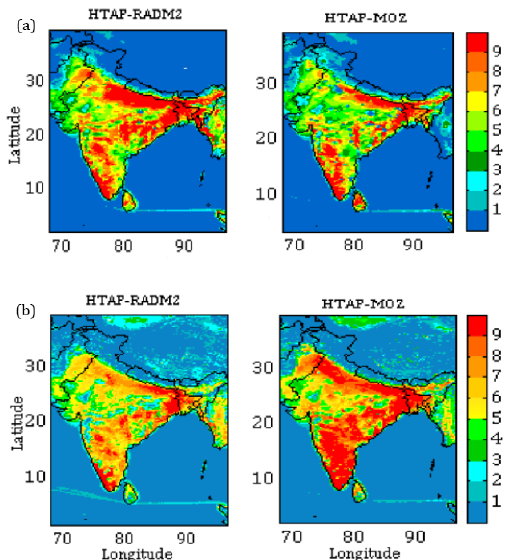
Figure 9. Average (a) net daytime surface ozone chemical tendency (in ppbvh − 1 ) (b) net daytime surface ozone chemical + vertical mixing tendency (in ppbvh − 1 ) for April during 06:30–12:30IST